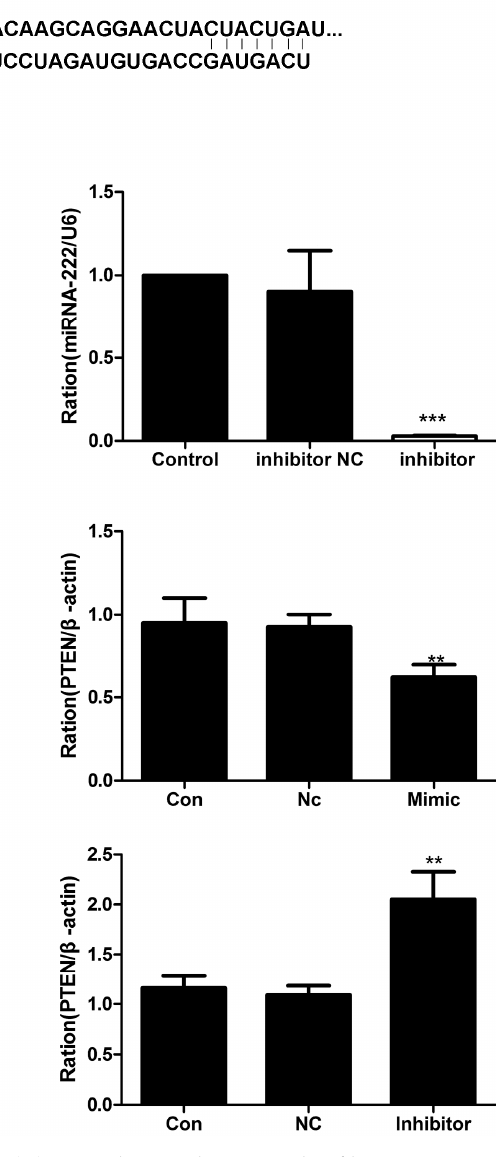
Figure 6. PTEN is a target protein of miRNA-222. ( A ) According to the principle of base pairing to deduce the binding of miR-222 to the predicted sequence in the 3 ′ -UTR of mouse PTEN mRNAs, seven complementary sites were demonstrated. ( B ) We successfully transferred the mimic and inhibition of miRNA-222 into H9c2 cells, as determined by quantitative-PCR. ( C ) The change in PTEN protein in H9c2 cells when miRNA-222 was upregulated and downregulated, respectively. NC = negative control. Data represent the mean ± SEM from the Con and infected groups, ** p < 0.01, *** p < 0.001.